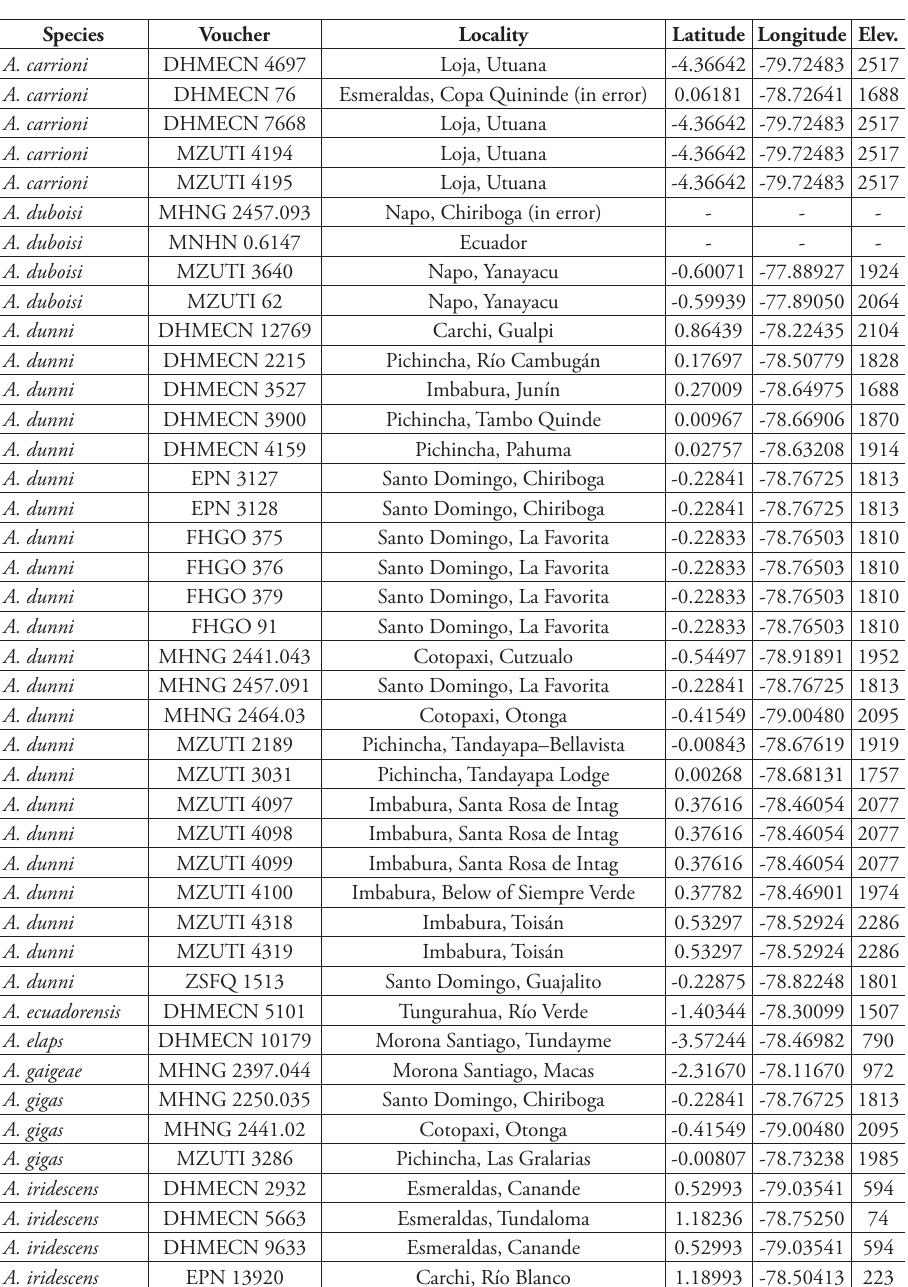
Table 1. Locality data for specimens examined in this study. Coordinates represent georeferencing at- tempts from gazetteers under standard guidelines, though some variation from the exact collecting locality will be present. Similarly, elevations are taken from Google Earth, and may not exactly match the eleva- tions as originally